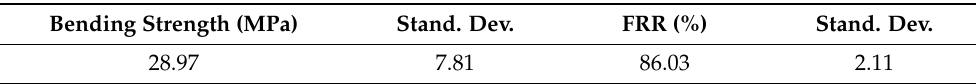
Table 2. Flux recovery ratio (FRR, %) and three-point bending strength (MPa) of TiO 2 /GO-Al 2 O 3 HF NF membranes.